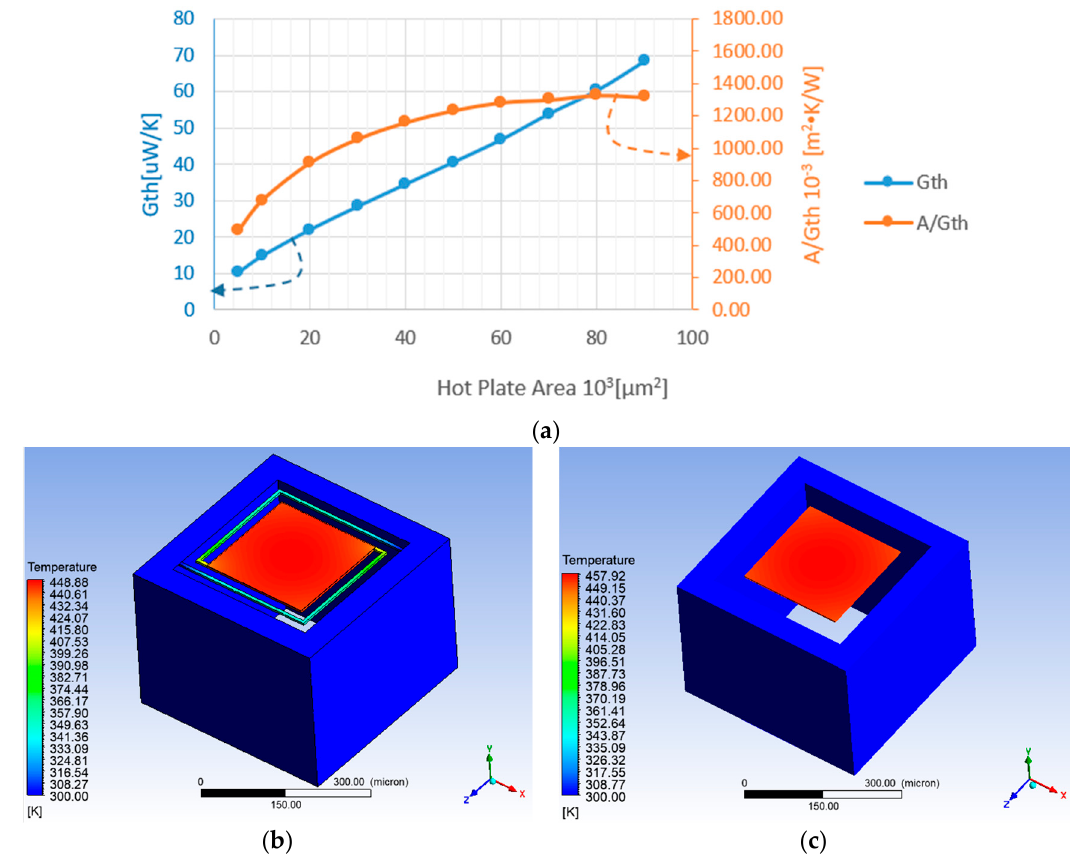
Figure 6. ( a ) Ideal hot plate thermal conductance and the FOM Area / G th . Vs. stage area for V heater = 3 V, and R heater = 1000 ohm. The hot plate is ideal since the e ff ect of the holding arms is neglected. ( b ) Steady state simulation temperature result of the DUT with holding arms, with the overall following dimensions: Plate area: 45.45 × 10 3 µ m 2 ; Holding arms width 6.4 µ m: Gap 18 µ m; for applied heater voltage of 3 V. ( c ) Steady state simulation temperature result of the DUT without holding arms.